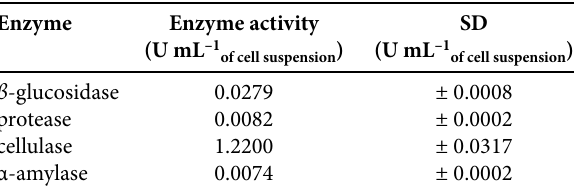
Table 3 : Initial activity of various enzymes in the W. ichthyophaga cell suspension before homogenization and standard deviation of measurements (SD).